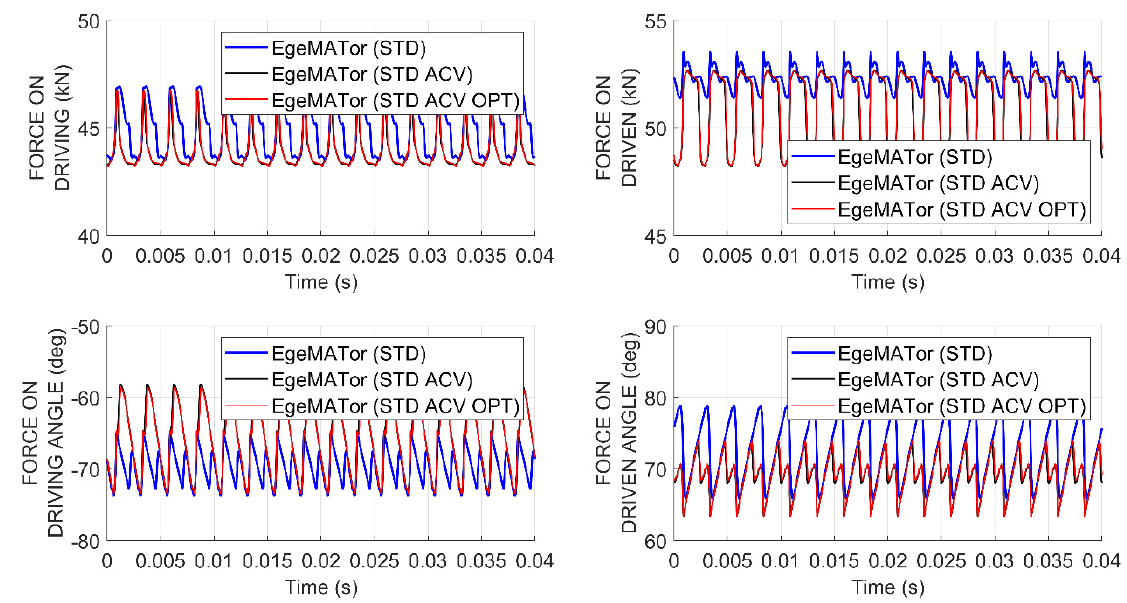
Figure 21. Numerical forces and their directions acting on driving and driven gears.